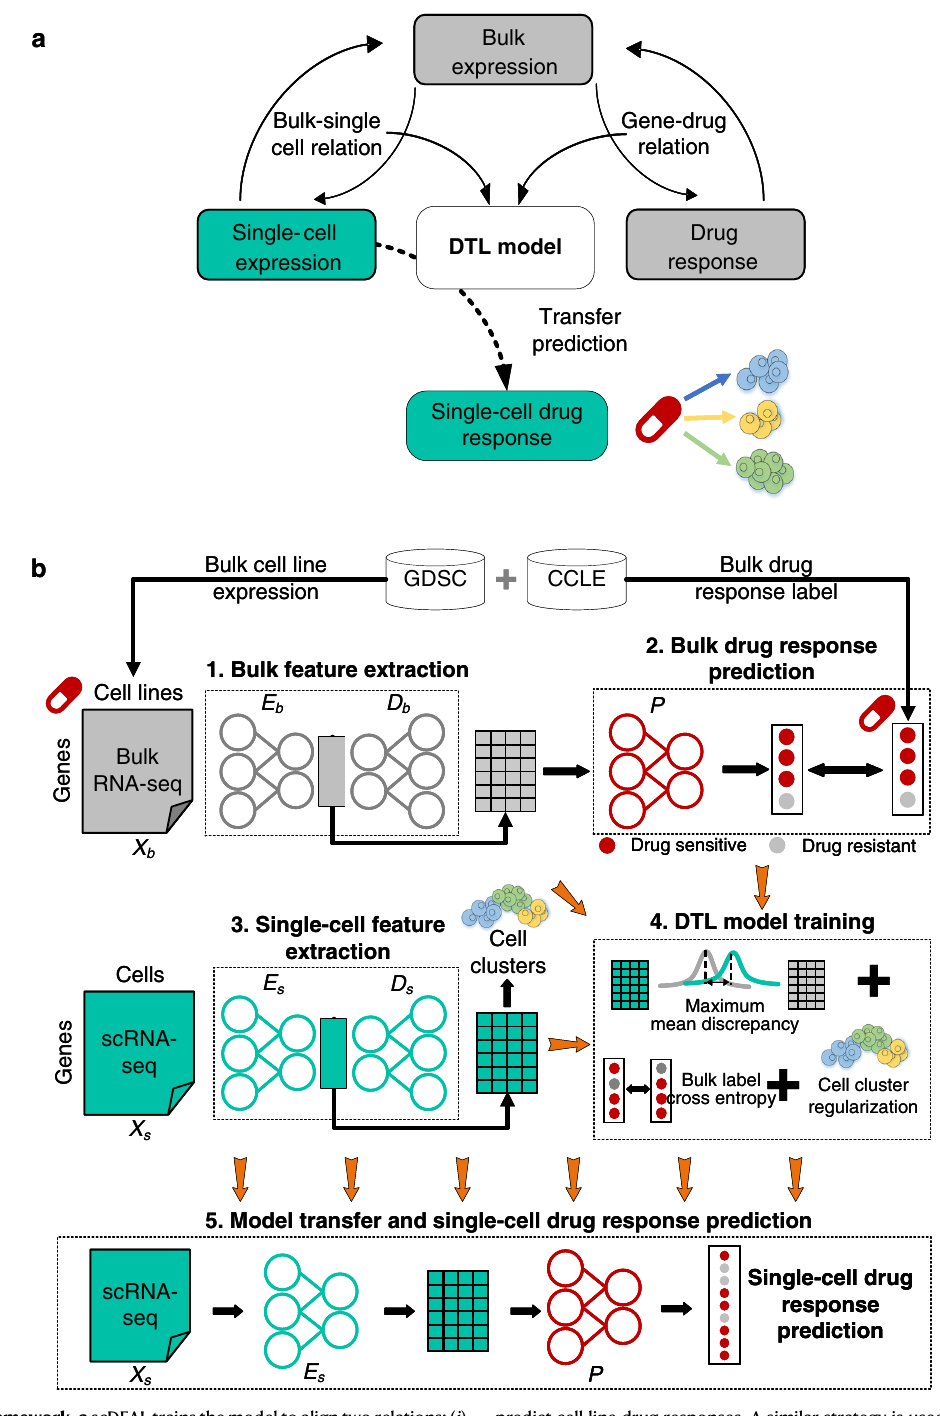
Fig.1|ThescDEALframework.a scDEALtrainsthemodeltoaligntworelations:( i ) bulk – single-cell relations and ( ii ) gene – drug response relations at the bulk level. The trained model will then be transferred to be directly applied to the scRNA-seq data and to predict the single-cell drug responses. Green-colored elements repre- sentsingle-cellrelateddata,andgrey-coloredelementsrepresentbulk-relateddata. Different colorsofcells represent different celltypes. b BulkRNA-seqdata and the corresponding drug response labels are obtained from the GDSC and CCLE data- bases.Fivestepsarethenapplied.ADAEisusedtoinducenoisesintothebulkdata. It uses anencoder ( E b ) and a decoder ( D b ) to obtain low-dimensional features. The bulk feature ⨯ cell-line matrix is then input to a fully connected predictor ( P )